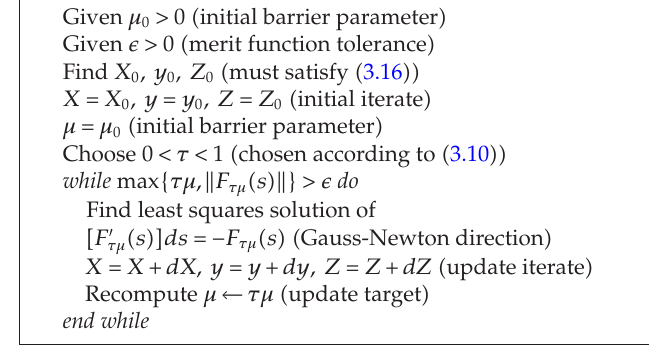
Algorithm 1.1 Gauss-Newton infeasible short